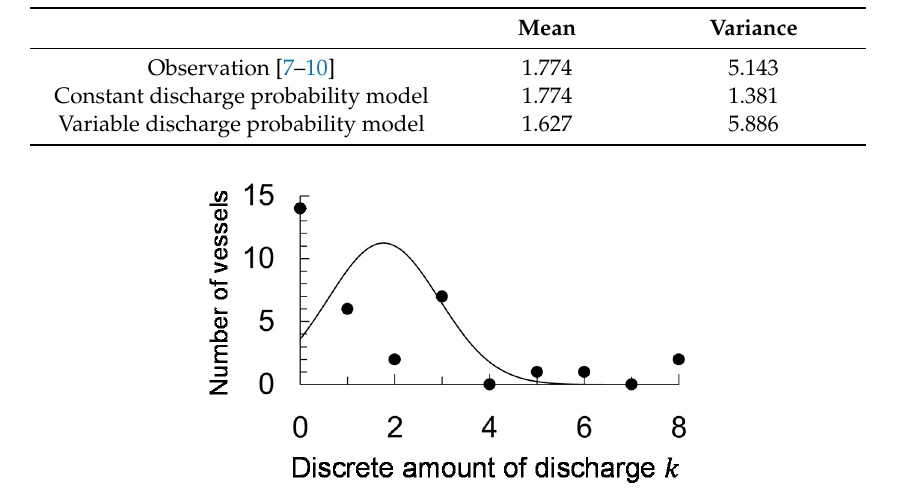
Figure 2. Number of vessels versus amount of discharge. Solid line is from the constant discharge probability model, and closed circles are from observation.